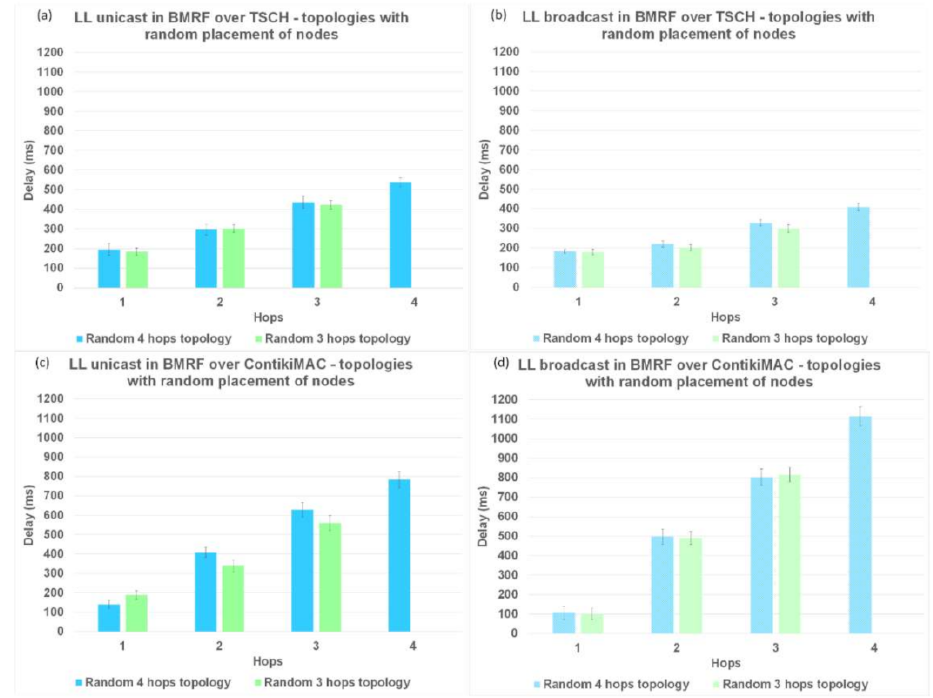
Figure 13. Delay comparison between LL unicast and LL broadcast and between ContikiMAC and TSCH on topologies with a random placement of nodes. ( a ) Results for LL unicast in BMRF over TSCH. ( b ) Results for LL broadcast in BMRF over TSCH. ( c ) Results for LL unicast in BMRF over ContikiMAC. ( d ) Results for LL broadcast in BMRF over